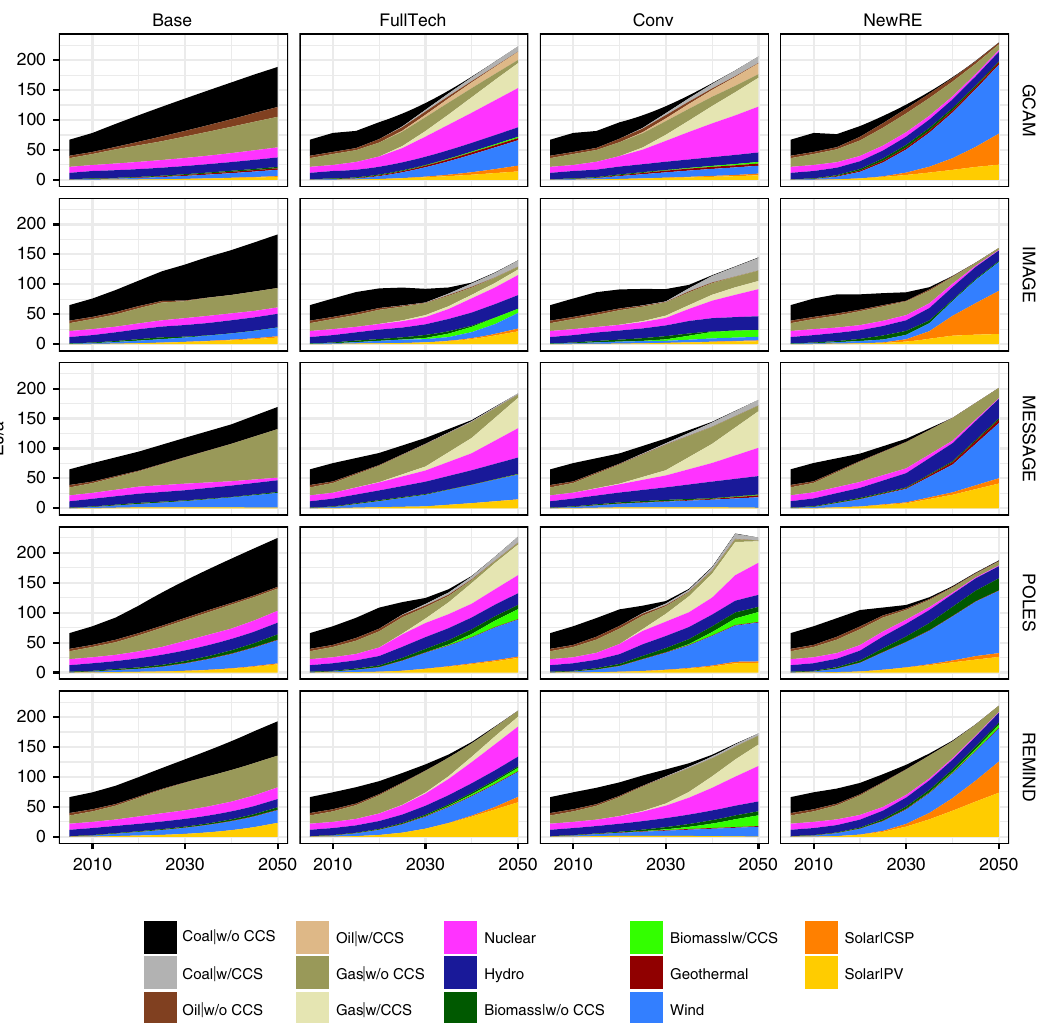
Fig. 1 Scenarios of future electricity generation. Projections of electricity generation for the baseline and three decarbonization scenarios compatible with limiting warming to well below 2 °C, as modeled by fi ve structurally different Integrated Assessment Modeling